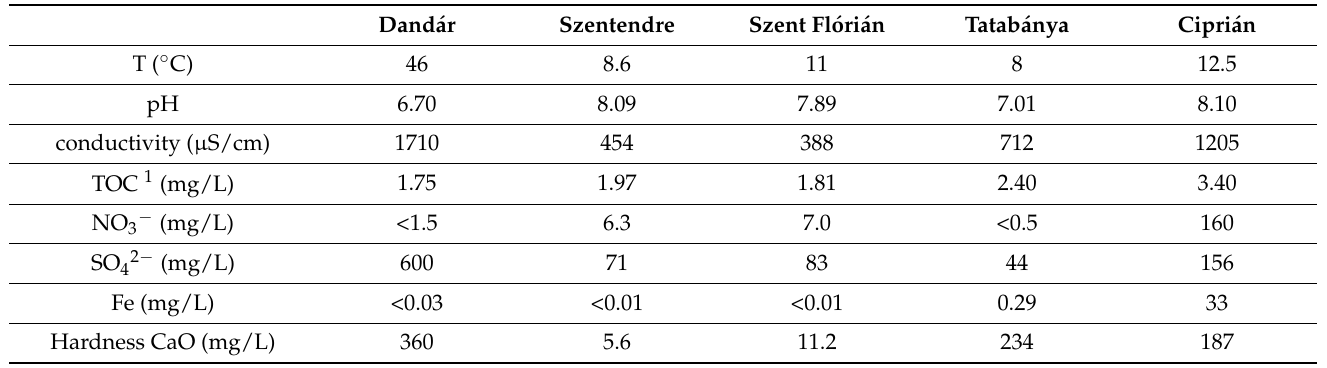
Table 1. Physical and chemical parameters of the sampling sites.